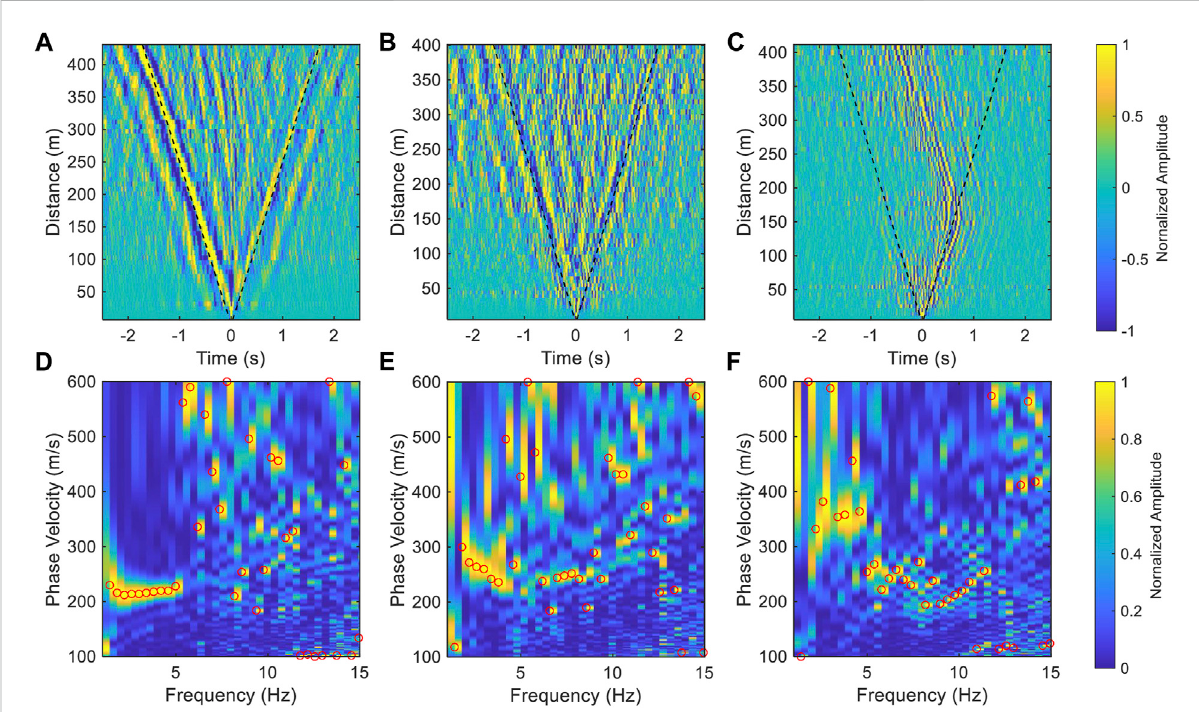
FIGURE 2 The example of common virtual-shot gathers and the dispersion spectra. (A – C) are the NCF waveform for segments 1, 2, and 3 in Figure 1, respectively. The black dashed lines in (A – C) represent a velocity of 250 m/s. (D – F) are the dispersion spectra of the three segments, respectively. The red circles indicate the maximum energy at each frequency.